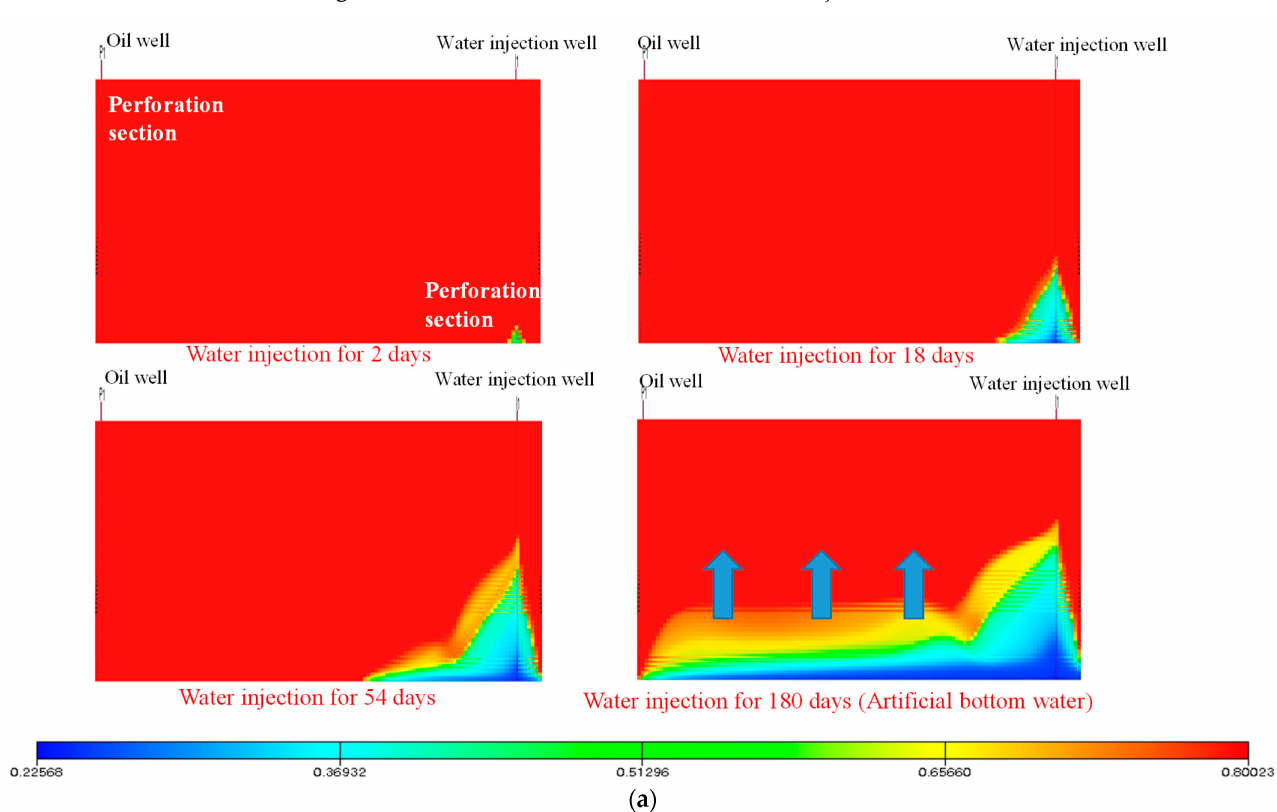
Figure 5. The mechanism model of bottom water injection.